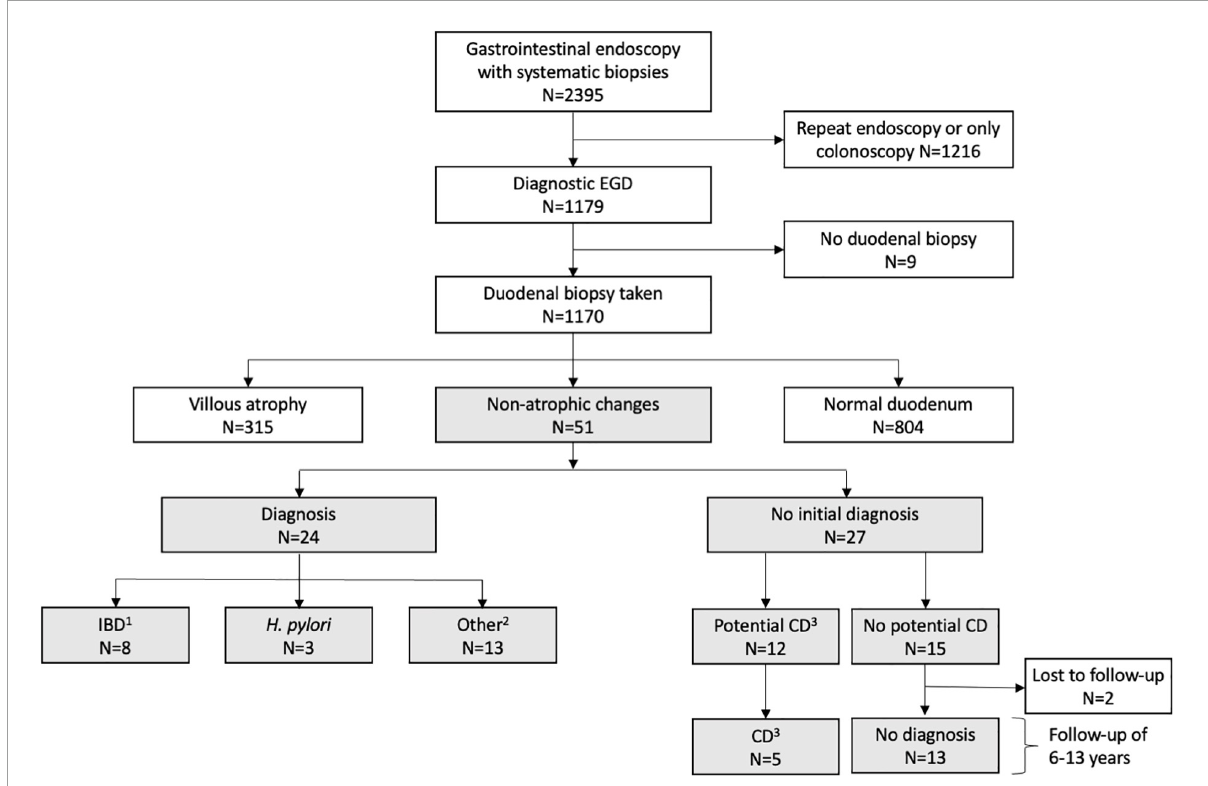
FIGURE1 Flowchart of the study. 1 Crohn’s disease ( n = 6), inflammatory bowel disease unclassified ( n = 2), 2 gastroesophageal reflux disease ( n = 4), wheat allergy ( n = 1), cow’s milk allergy ( n = 1), other food allergy ( n = 1), mastocytosis ( n = 2), postinfectious EBV colitis ( n = 1), mevalonate kinase deficiency ( n = 1), gastric ulcer ( n = 1), polyposis ( n = 1); 3 elevated serum tissue transglutaminase antibody and/or endomysial antibody levels without diagnostic duodenal lesion. CD, celiac disease; EGD, esophagogastroduodenoscopy; IBD, inflammatory bowel